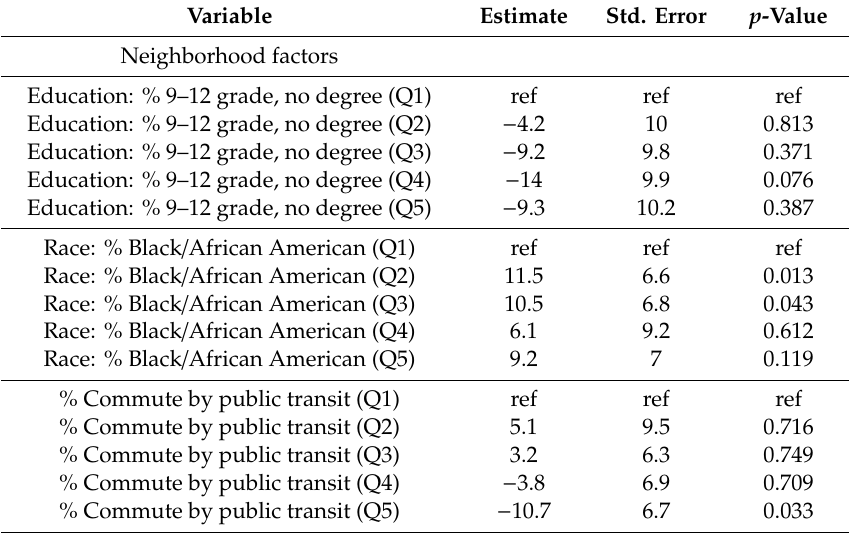
Table A2. Fully-adjusted linear mixed model selected via stepwise model selection, overall well-being score and neighborhood